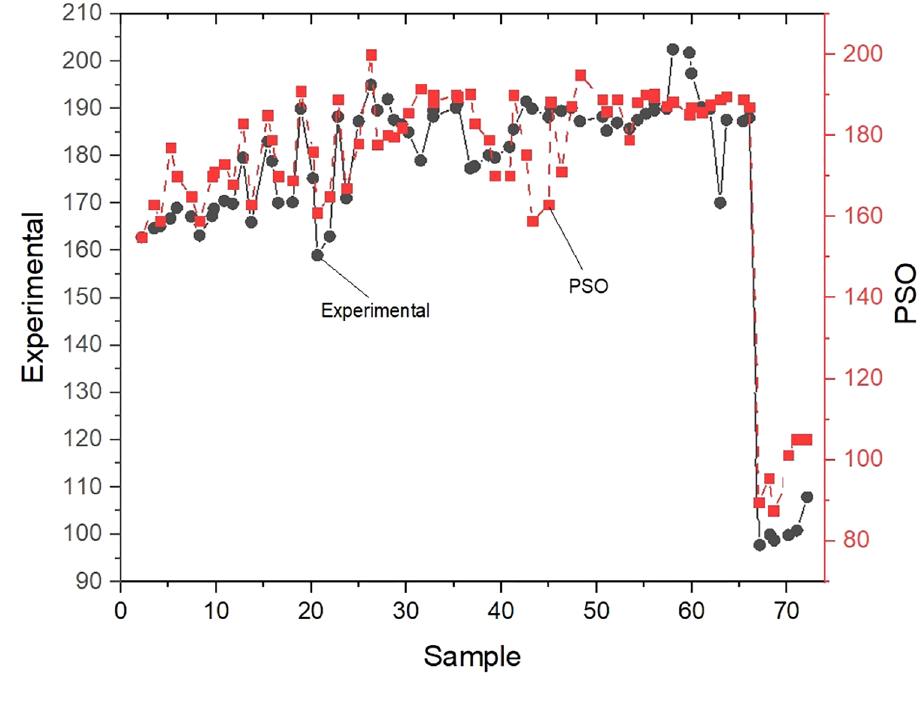
Fig. 12 Comparison between the particle swarm optimiza- tion data and the real data in the